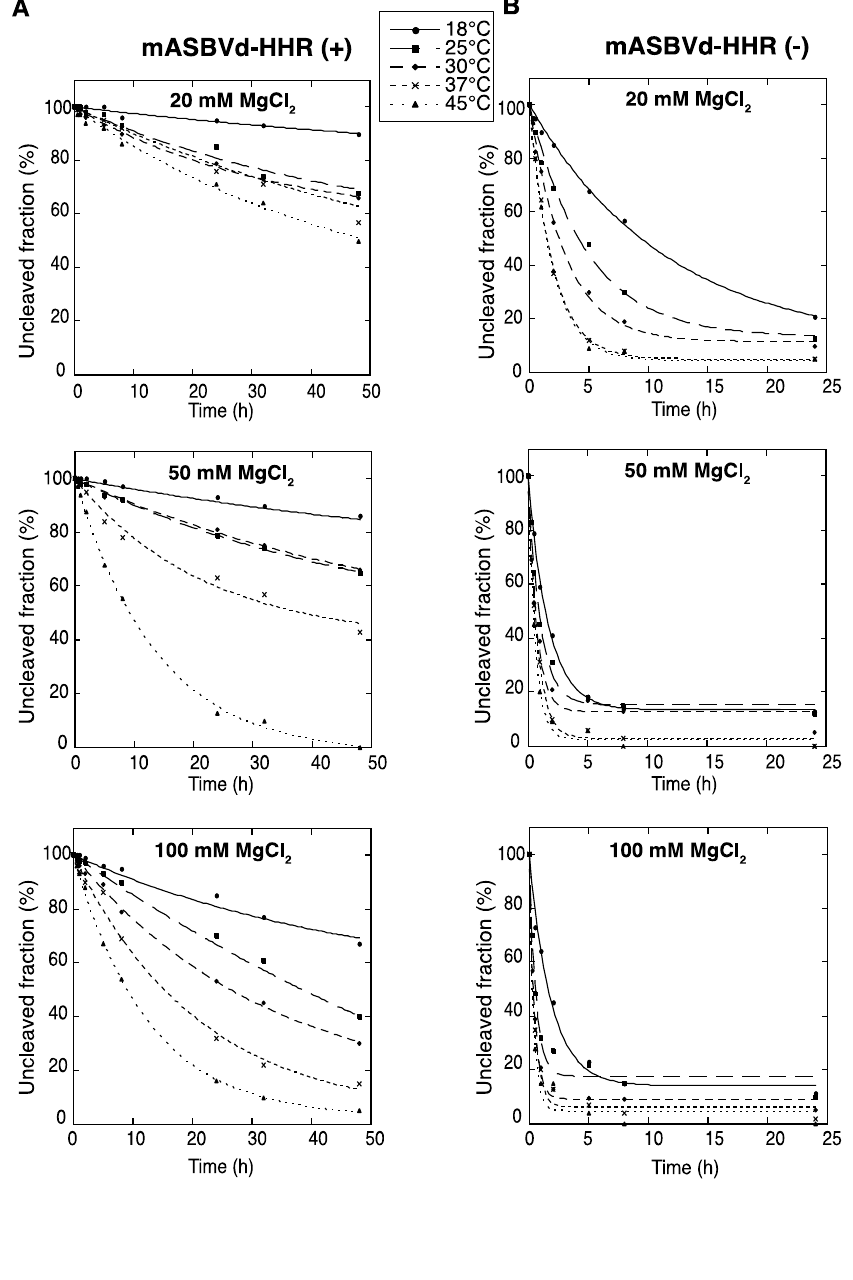
Figure 1. Self-cleavage kinetics of purified monomeric ASBVd-HHR (+) ( A ) and ASBVd-HHR ( − ) ( B ) transcripts. Self-cleavage reactions were carried out at 18 °C, 25 °C, 30 °C, 37 °C and 45 °C in buffers containing either 20 mM, 50 mM or 100 mM MgCl Aliquots were removed at different time up to 48 h for ASBVd (+) (panels A ) and 24 h for ASBVd ( − ) (panels B ), quenched with an excess of stop solution and separated on 10% polyacrylamide gels. After ethidium bromide staining, the percentage of uncleaved molecules was quantified using the ImageJ Software [25]. Quantitative data were fitted to multiexponential curves with the KaleidaGraph program (Synergy Software, Reading, PA,